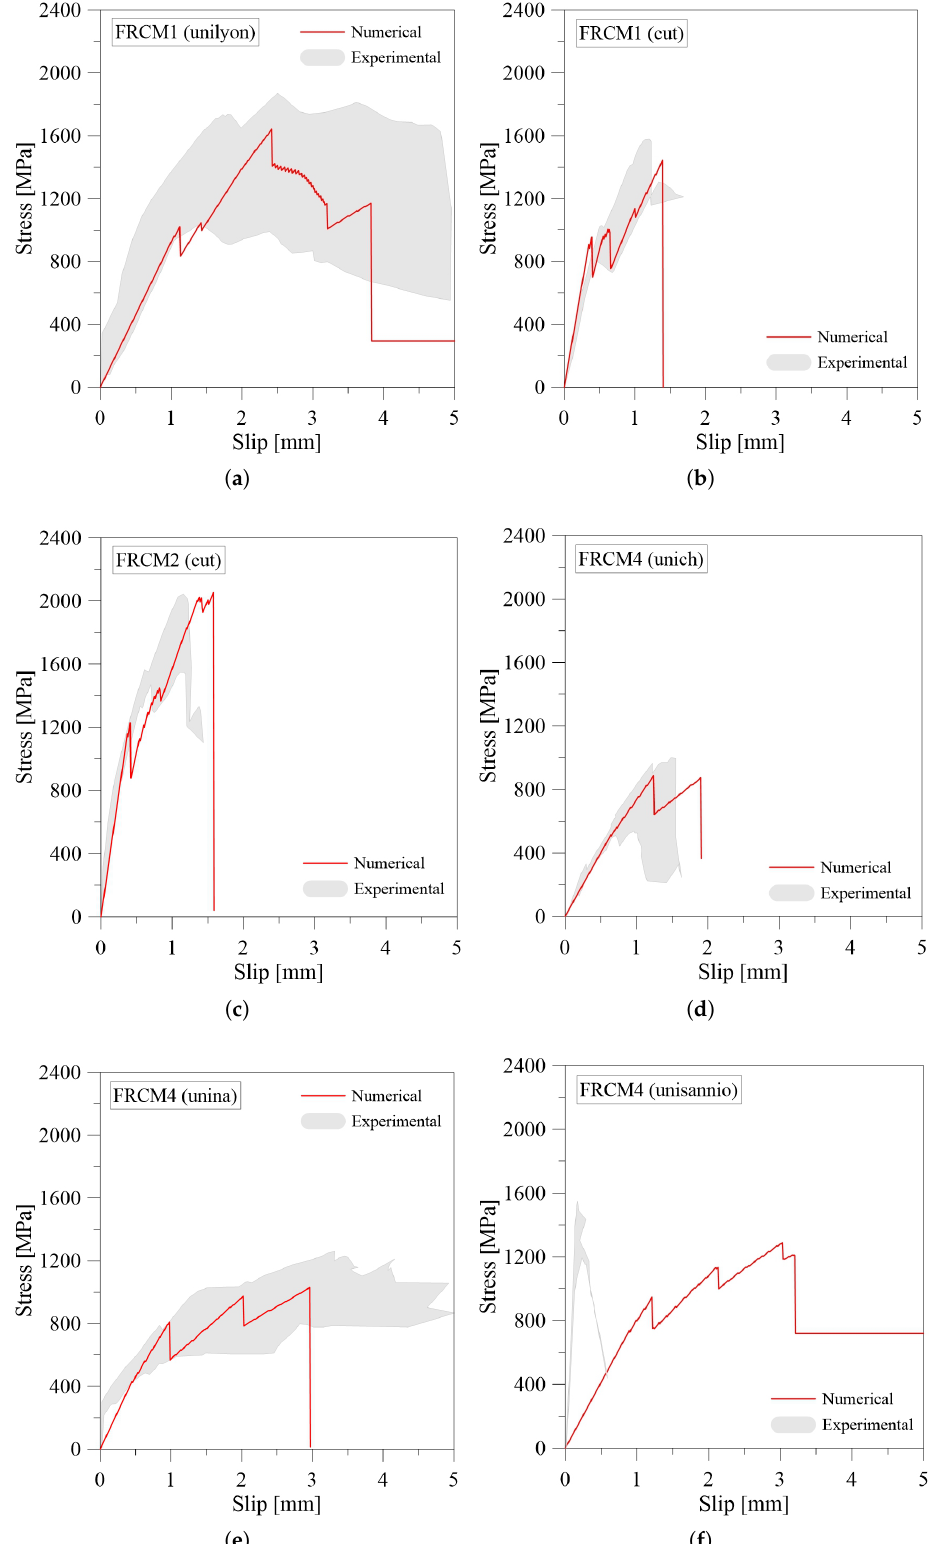
Figure 7. Numerical-experimental comparison of shear-bond behavior for